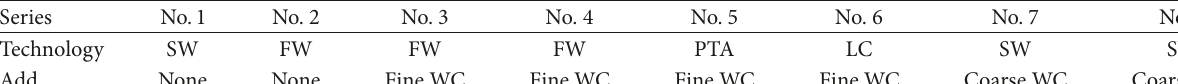
Table 2: Overview of test series.